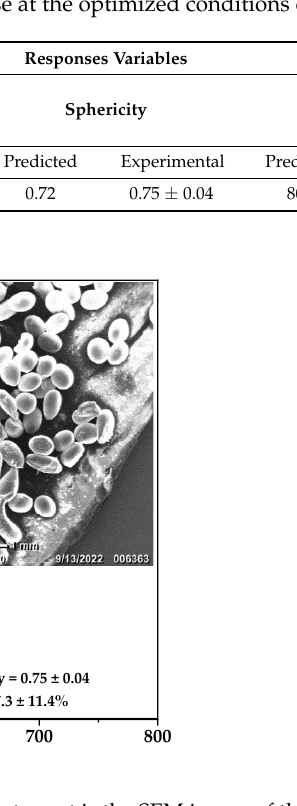
Figure 6. The microcapsule size distribution; the intersect is the SEM image of the obtained micro- capsules at the optimized conditions.